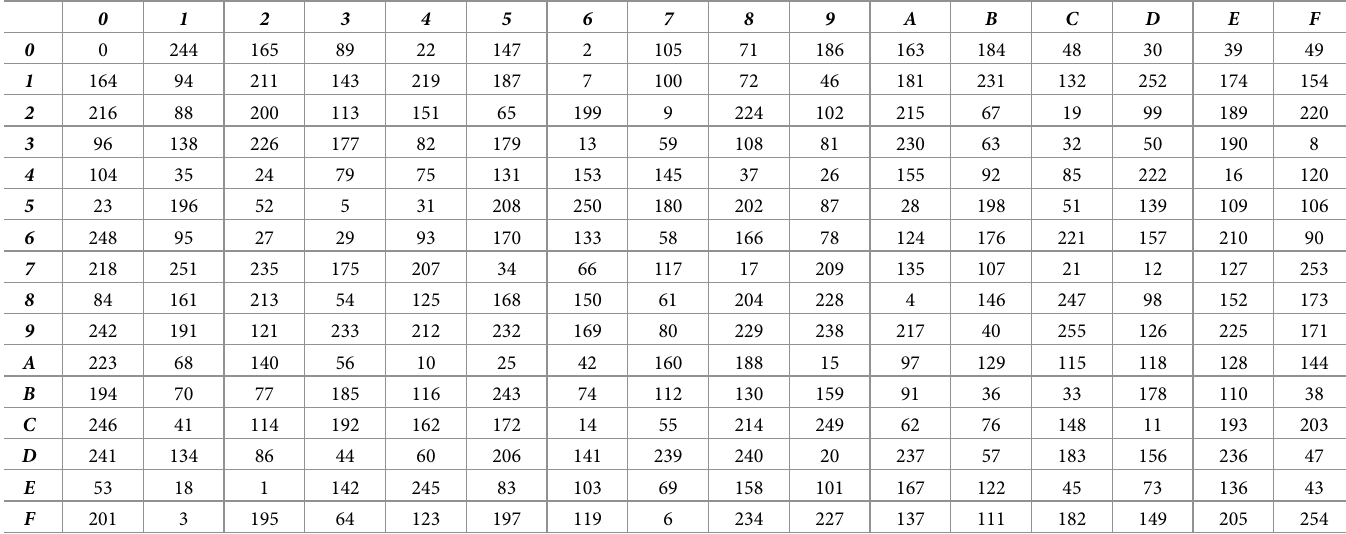
Table 2. Proposed S-box (S1) in 16 × 16 matrix form—Generated with T 1 .